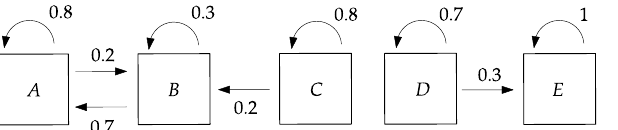
Figure 9. Reduced Markov chain comprising 5 states with transition probabilities of moving among states indicated which is used to illustrate the idea of the eigenvector method. Figure generated using Ipe 7.2.7 (http://